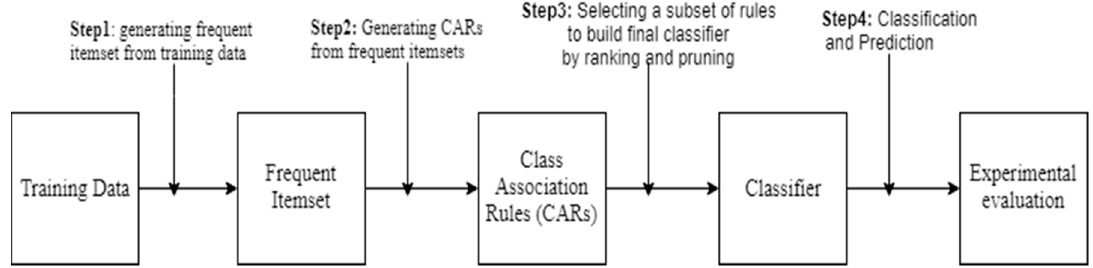
Figure 1. Associative Classification working procedure.